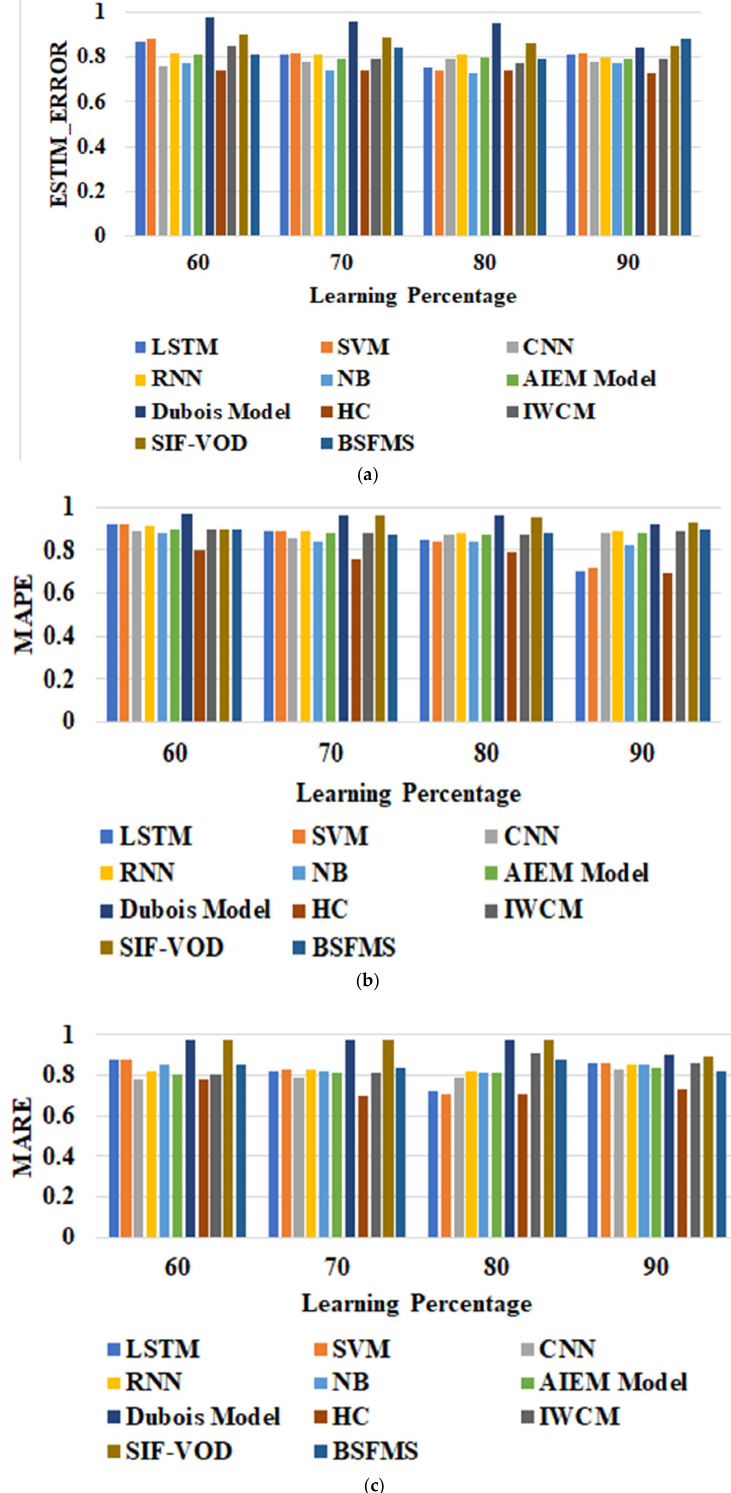
Figure 3. Analysis of HC (Bi ‐ GRU and DMN) over conventional methods ([21,24,28,37,41]) for ( a ) estimated error, ( b ) MAPE, and ( c ) MARE.